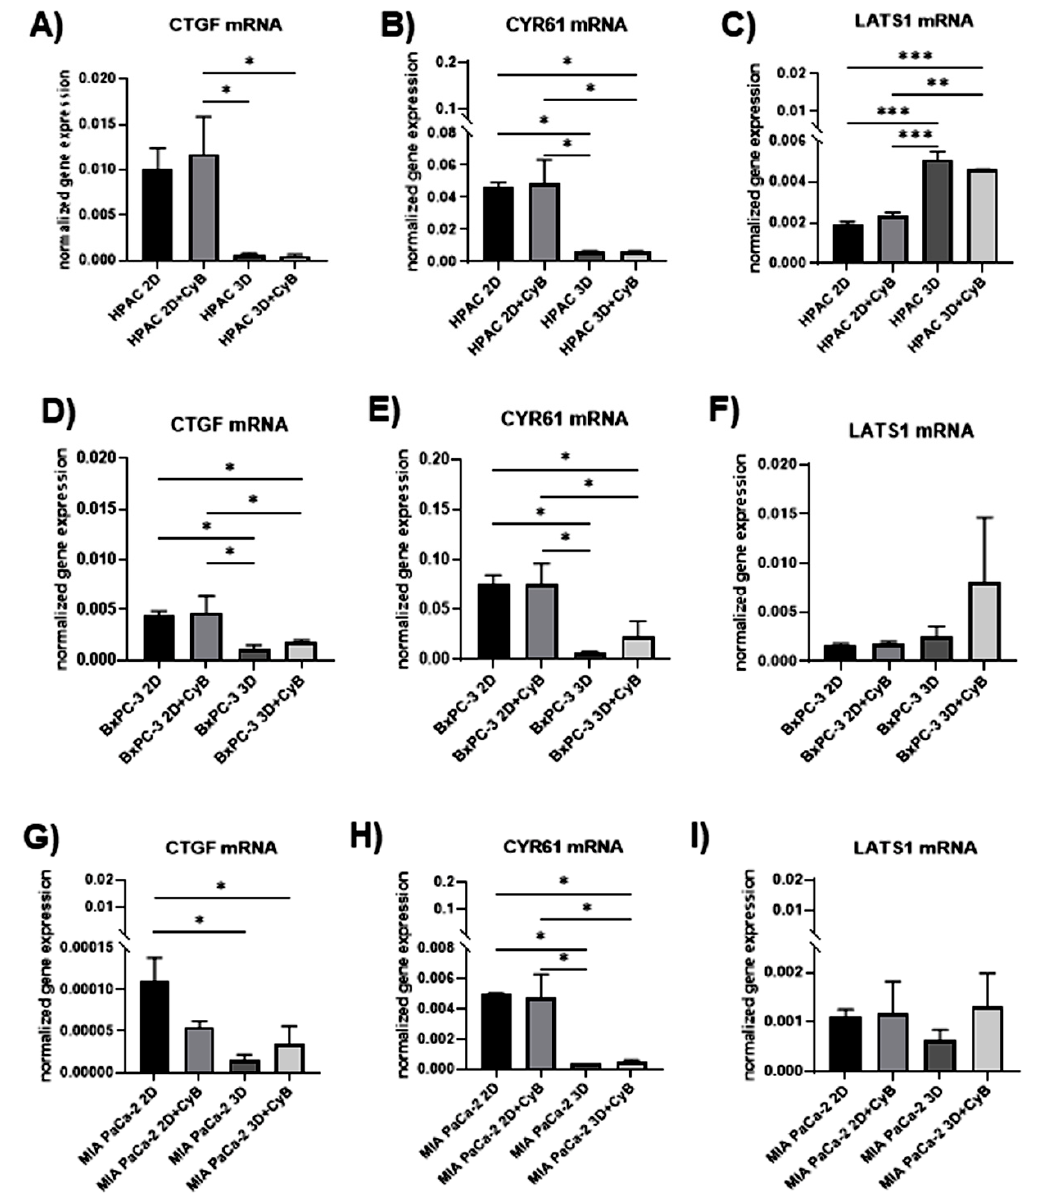
Figure 11. Bar graphs showing, respectively, CTGF, CYR61 and LATS1 gene expression in HPAC ( A – C ), BxPC-3 ( D – F ) and MIA PaCa-2 cells ( G – I ) assessed by real-time PCR. Data were normalized on GAPDH gene expression and are expressed as mean ± SD for at least three independent experiments. * p < 0.05, ** p < 0.01, *** p < 0.001.